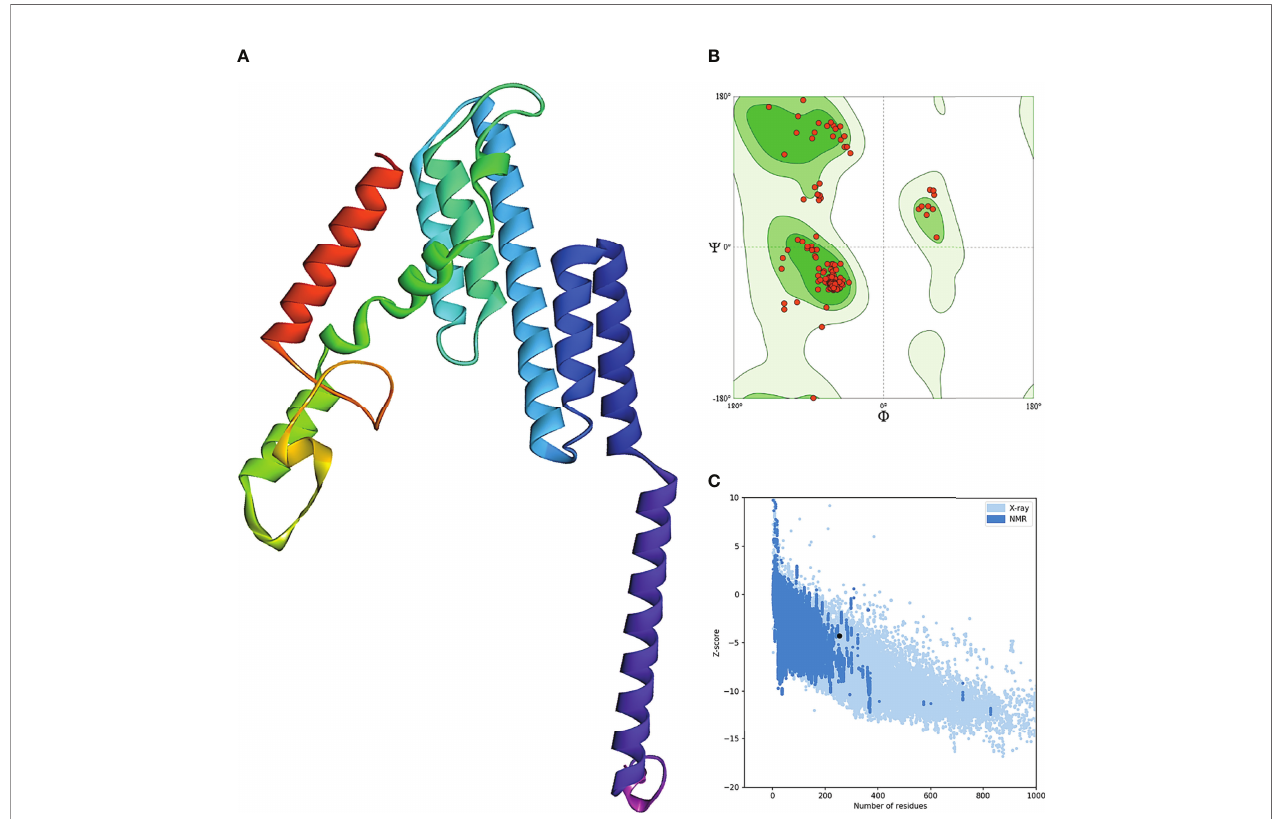
FIGURE 5 | Re fi nement and validation of the modeled tertiary structure of BFV. (A) represents the re fi ned 3D structure of BFV. (B) displays the Ramachandran plots of re fi ning the 3D structure of BFV using the SWISS-MODEL Workspace. Finally, (C) depicts the Z-Score plot for the 3D structure of BFV, which contains the z-scores of all experimental protein chains determined by NMR spectroscopy (dark blue) and X-ray crystallography (light blue).